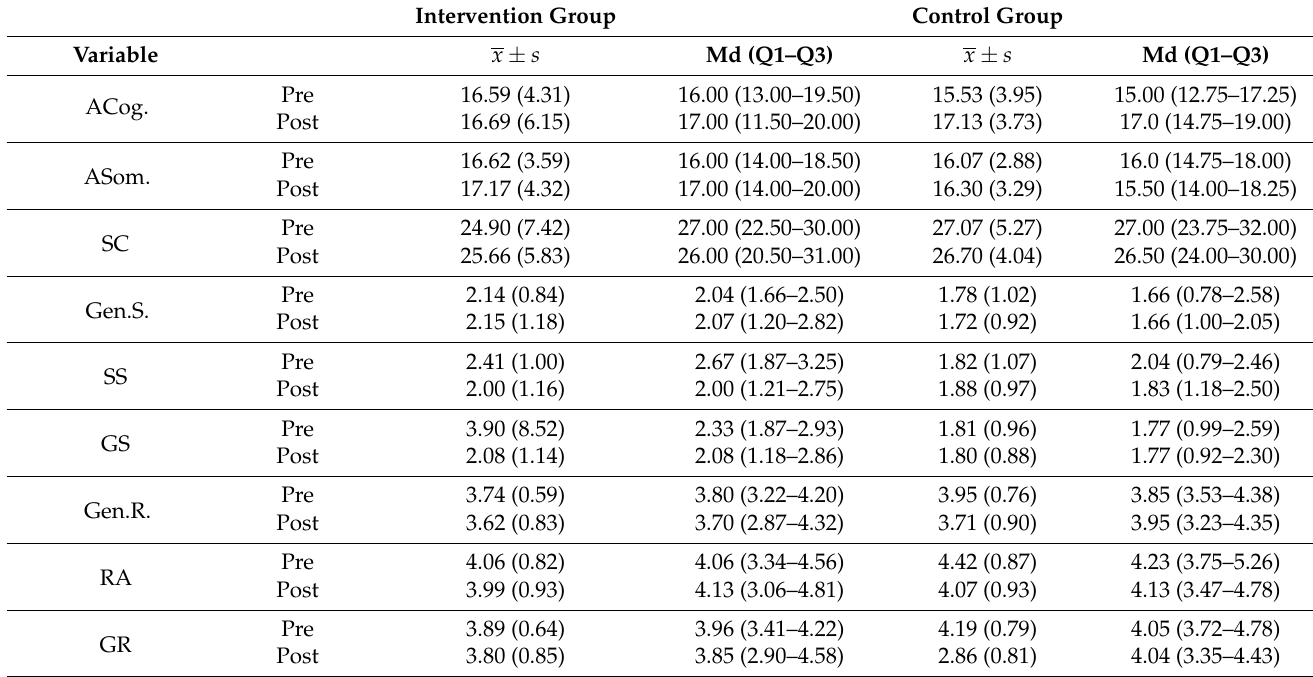
Table 2. Mean, standard deviation, median, and quartiles (Q1–Q3) of the three subscales of state anxiety (CSAI-2) and the six subscales of stress and recovery (RESTQ-Sport) for athletes in the intervention and control groups.